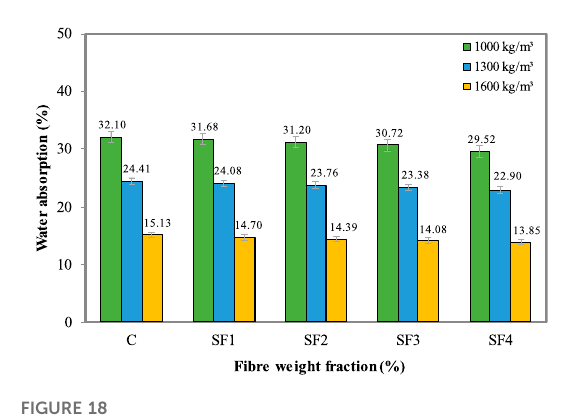
FIGURE 16 Correlation between fl exural and tensile strengths of FC.